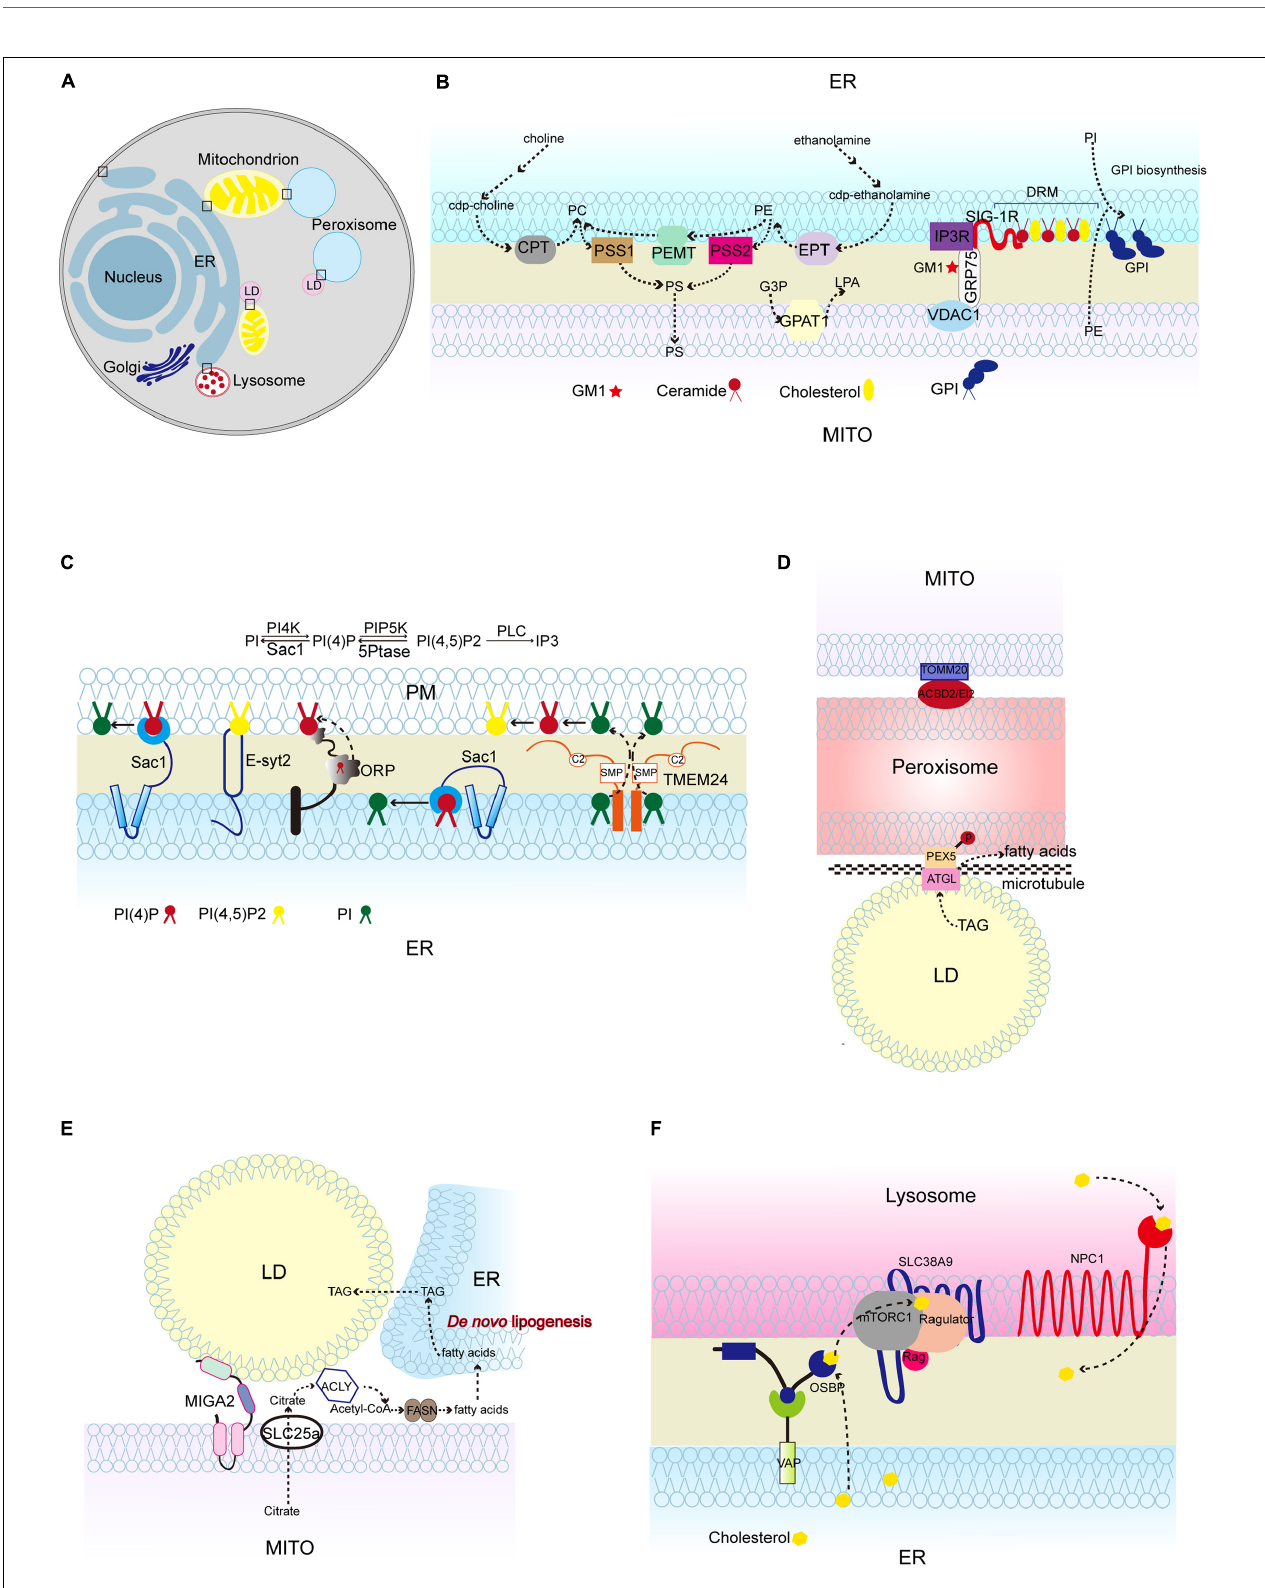
FIGURE 1 | Lipid synthesis and breakdown at MCSs in mammalian cells. (A) Schematic illustration of mammalian MCSs. The contact sites discussed in the text are boxed. (B) Lipid metabolism at the ER-mitochondrion contacts, highlighting the linked synthesis of PC, PE, and PS; the detergent-resistant membrane (DRM)